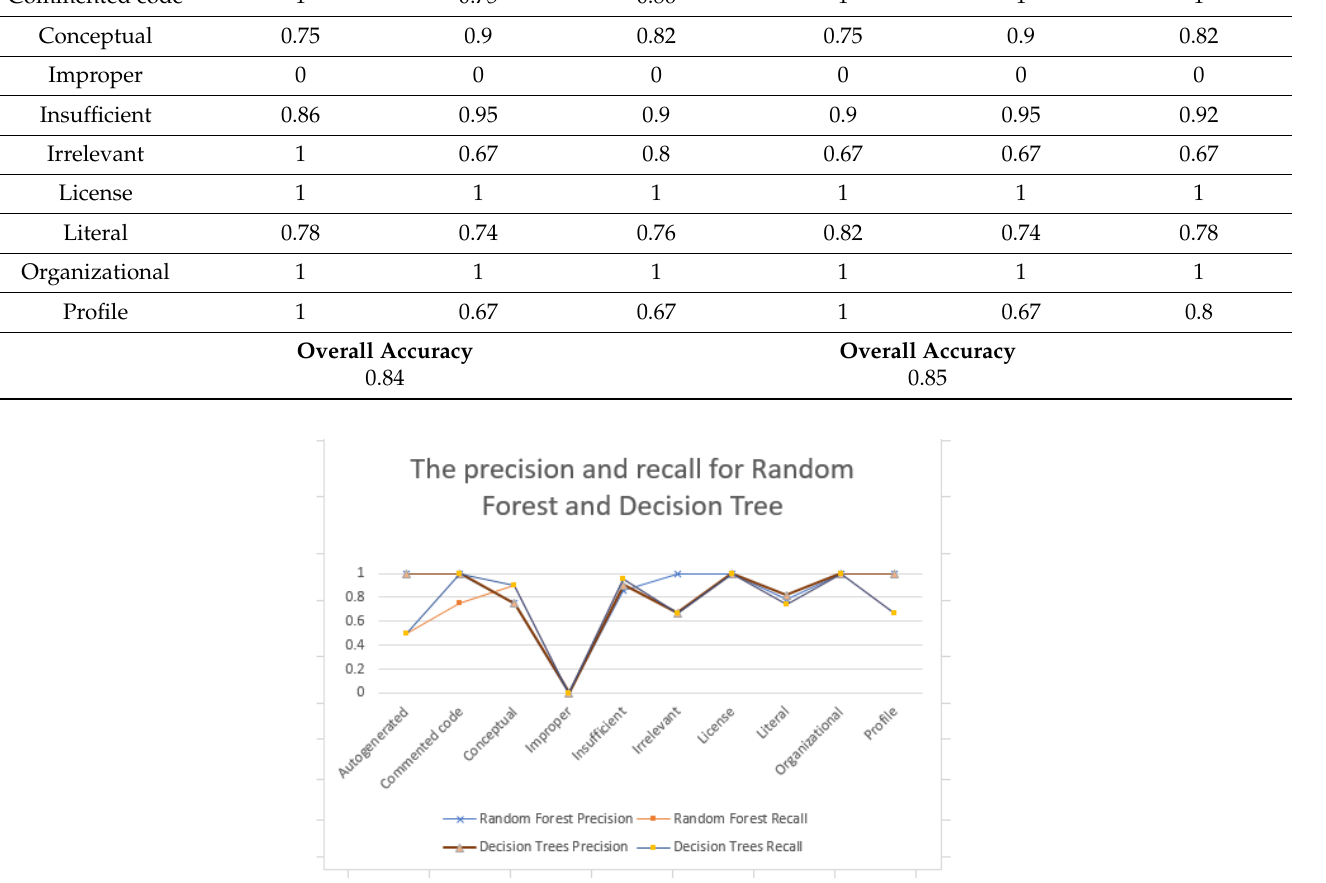
Table 9: The Precision, Recall anf F1-Score for Random Forest and Decision Tree 541 Random Forest Decision Trees